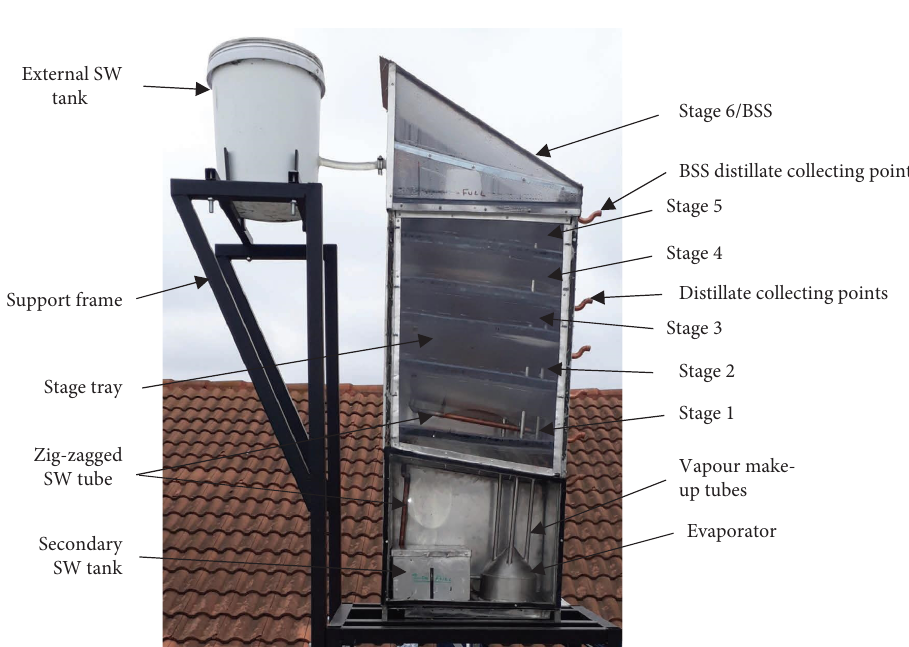
Figure 2: Vapour-based